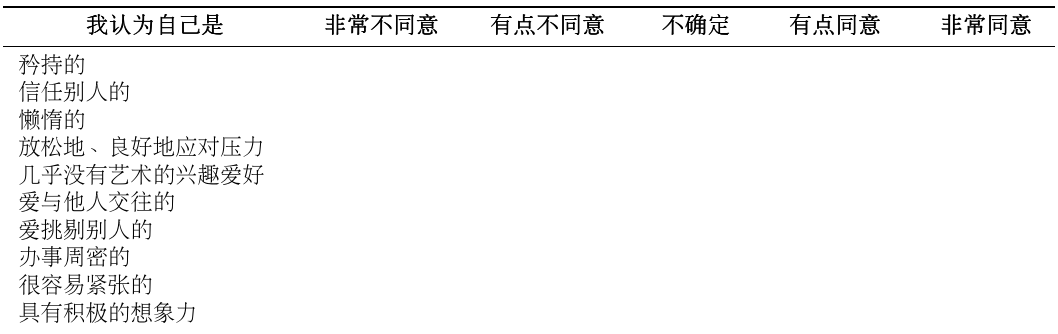
Table A1. BFI-10 Chinese Version.